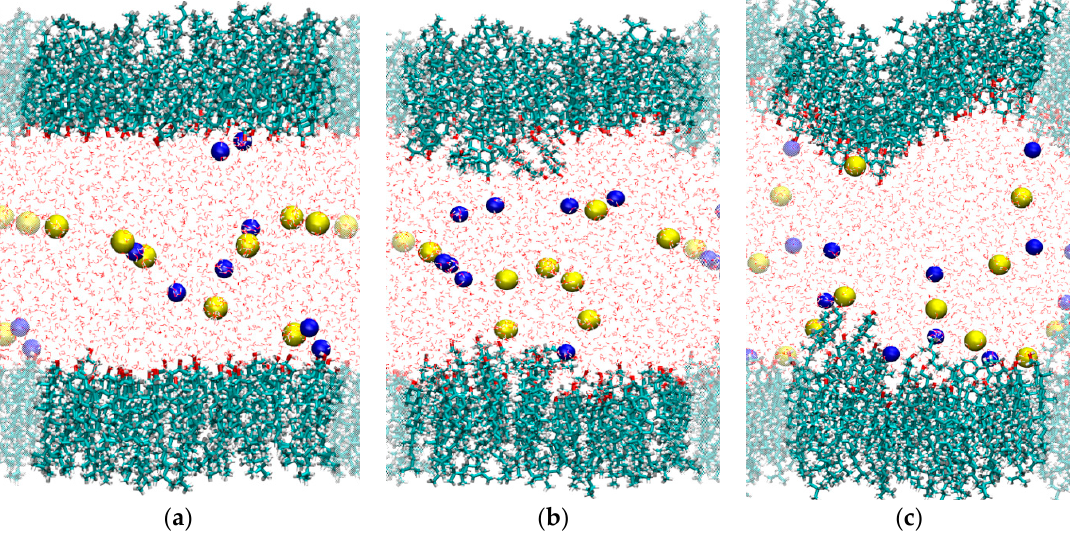
Figure 2. Snapshots from MD simulations ( T = 298 K) corresponding to different area per molecule: ( a ) 40 Å 2 /molecule; ( b ) 35.3 Å 2 /molecule and; ( c ) 33.1 Å 2 /molecule. CHOL molecules are shown in bond representation; water is shown as lines and ions as spheres with Van der waals radii (yellow spheres: Na + ; blue spheres: Cl − ). The shaded region indicates the employed periodic boundary conditions. This figure was made with VMD software [29].